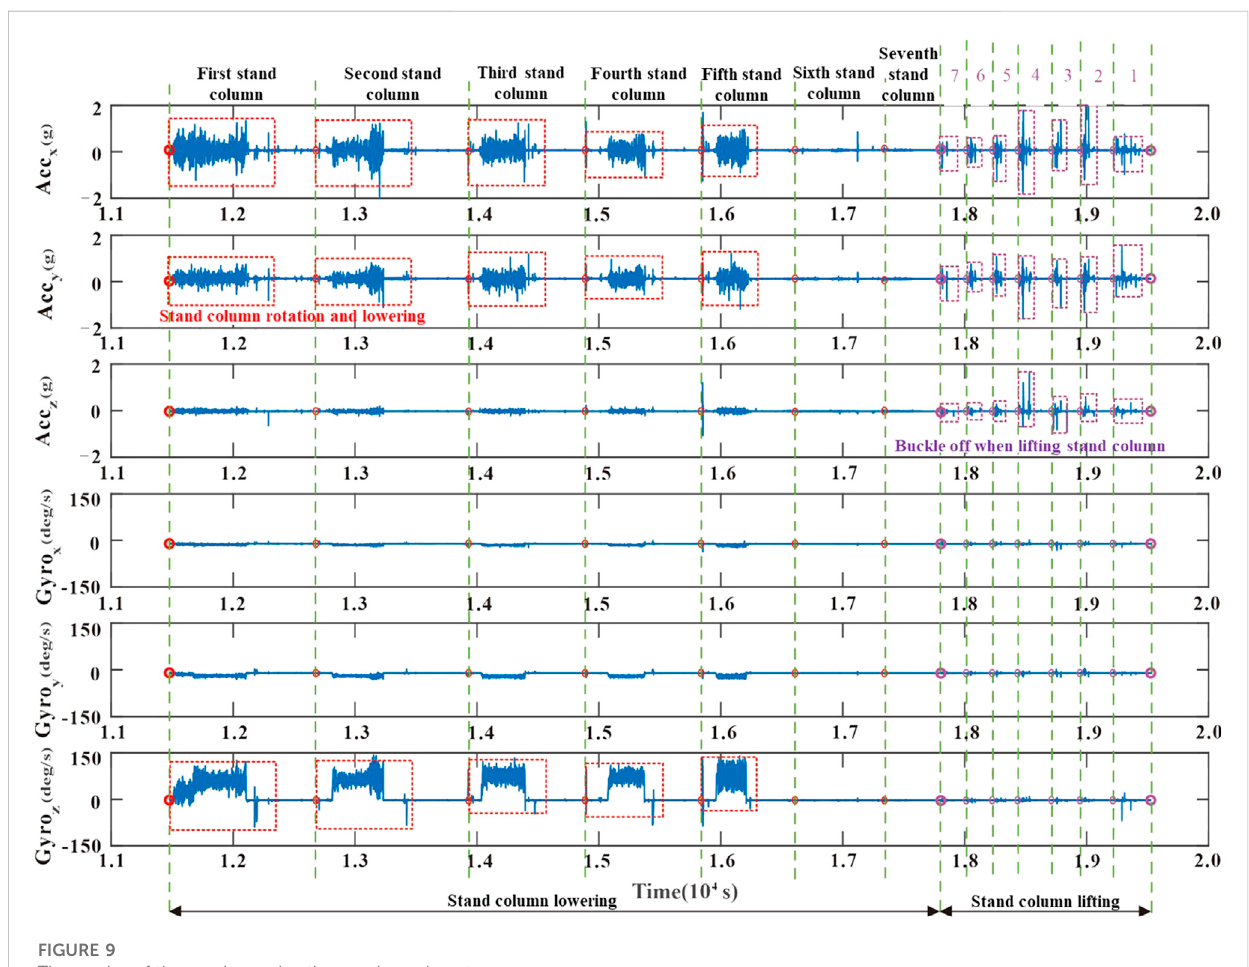
Time series of three-axis accelerations and angular